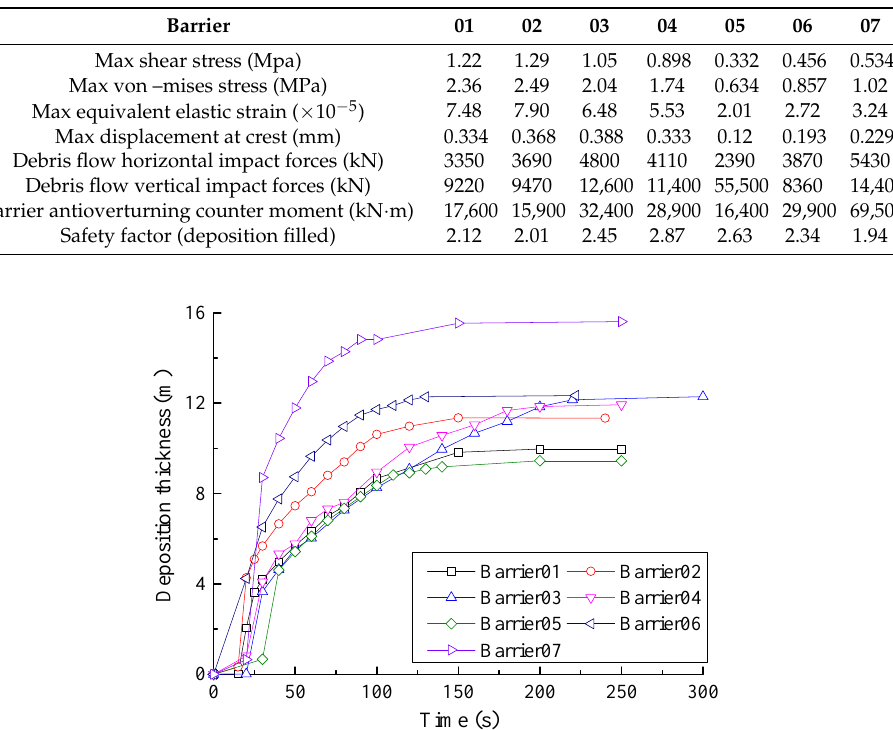
Figure 10. Deposition thickness at the front of the barrier.